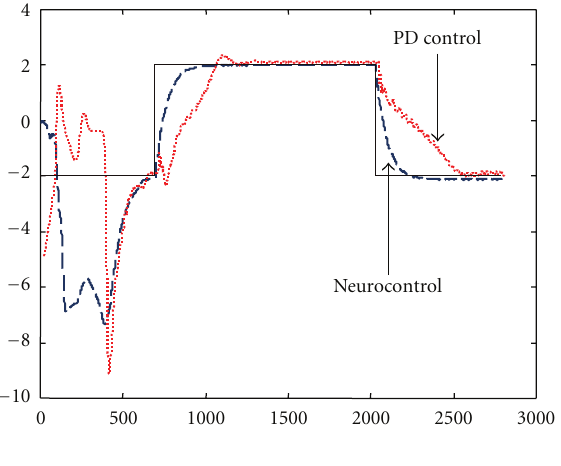
Figure 3: Tracking control of θ 2 (method B).